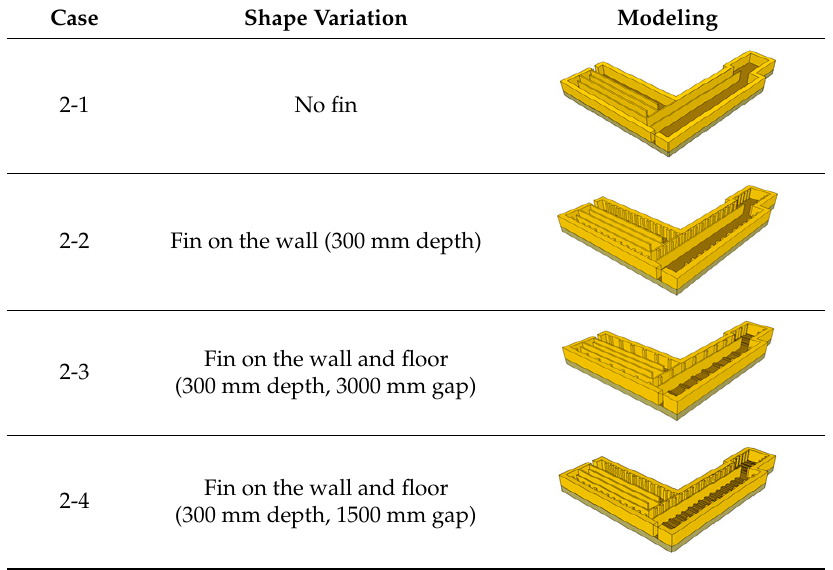
Figure 7. Air blower axial power and COP changes with length.